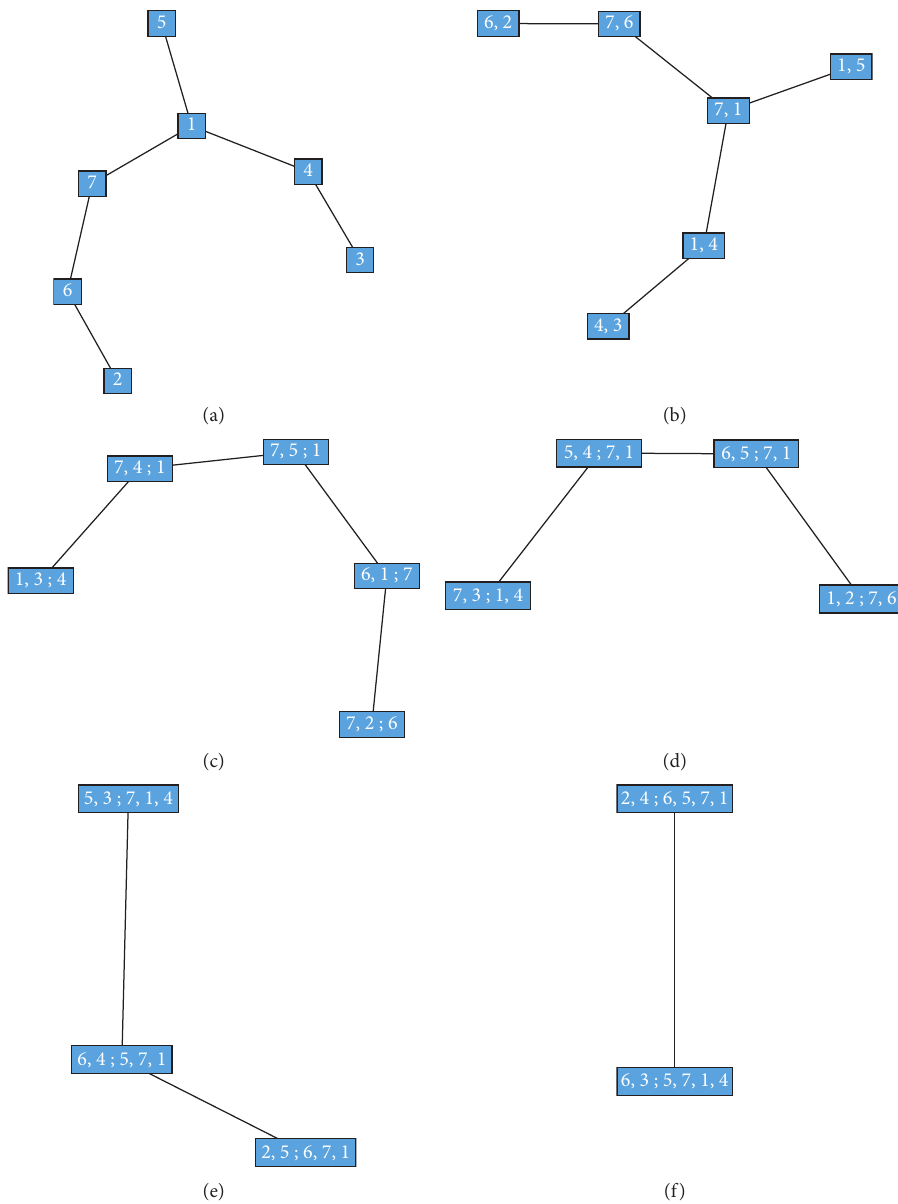
Figure 6: The R-vine tree structure of the Newthyroid